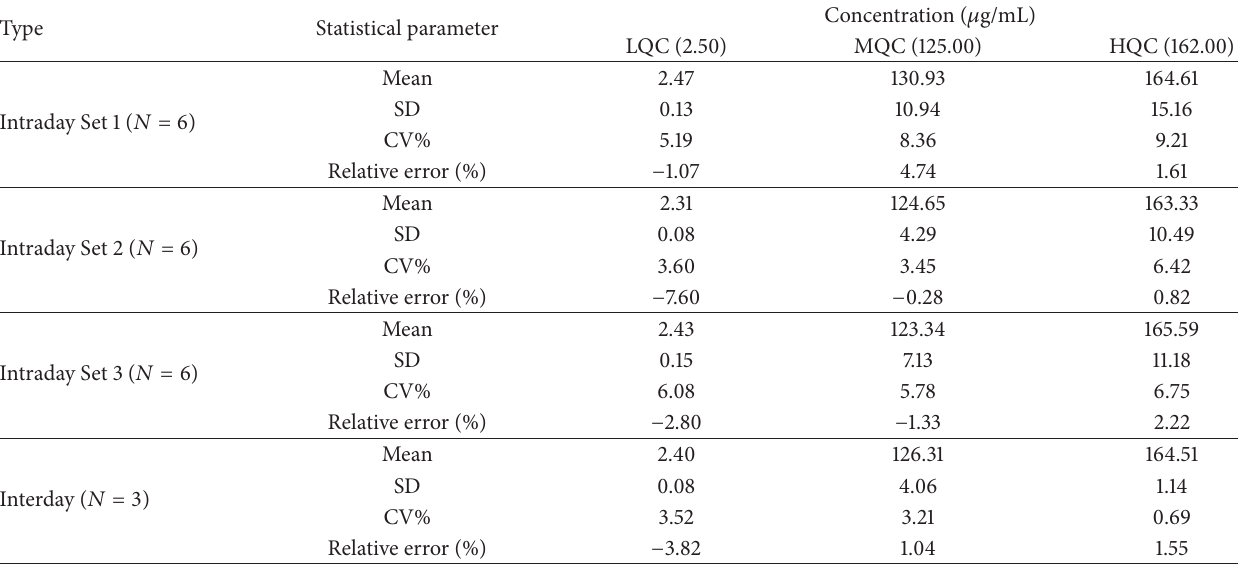
Table 2: Precision and accuracy of CrEL-PEG in quality control